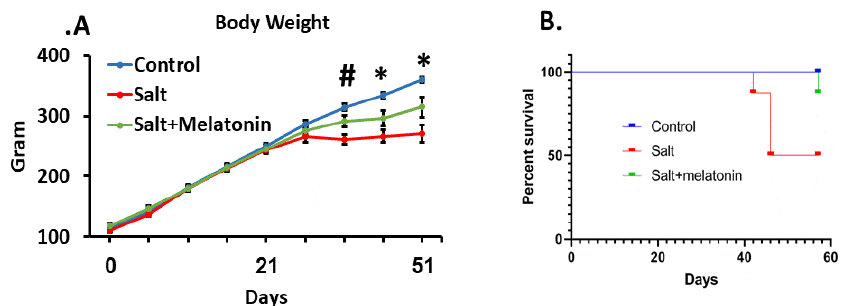
Figure 1. Melatonin ameliorated blood pressure and survival in HSD. DSS Rats were treated for 9 weeks with HSD with and without melatonin. High-salt diet reduced body weight from day 36 and melatonin moderated this effect ( A ). HSD increased mortality rate from day 40. Treating HSD-fed rats with melatonin improve their survival. ( B ). ( n = 8) *- p ≤ 0.05 salt and salt+melatonin versus control. #- p ≤ 0.05 salt versus control and salt+melatonin. HSD—high-salt diet.